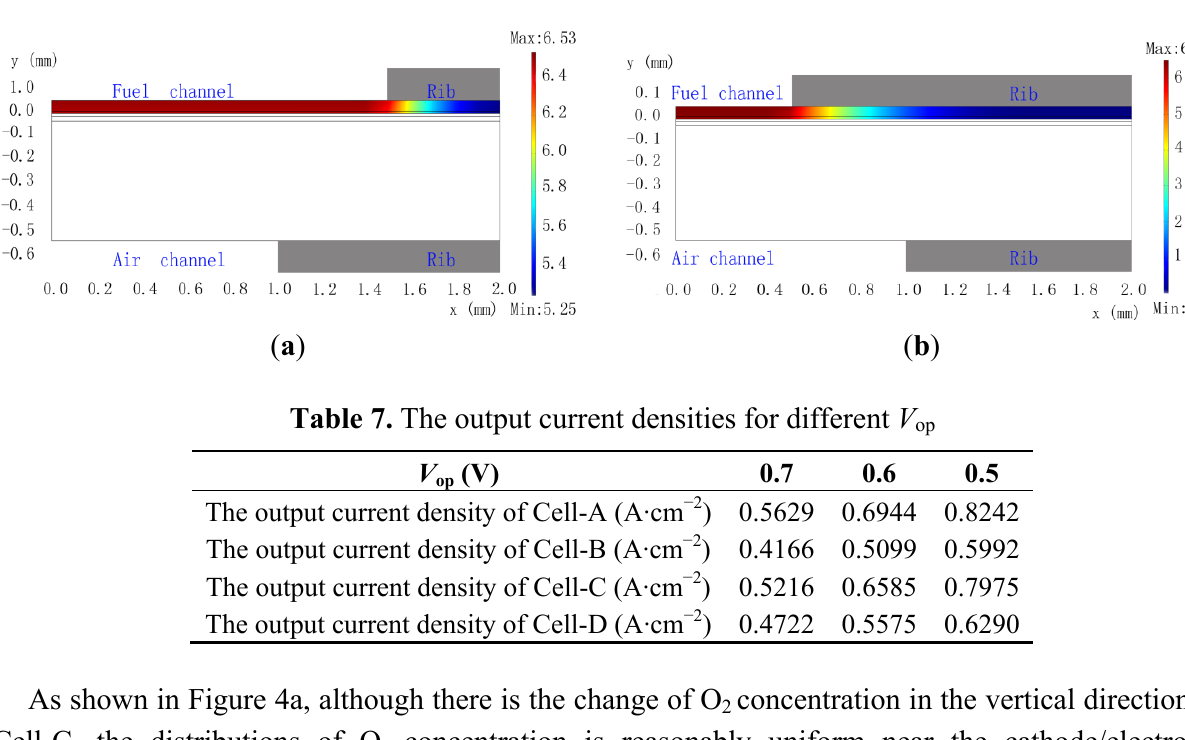
Figure 3. Distributions of H